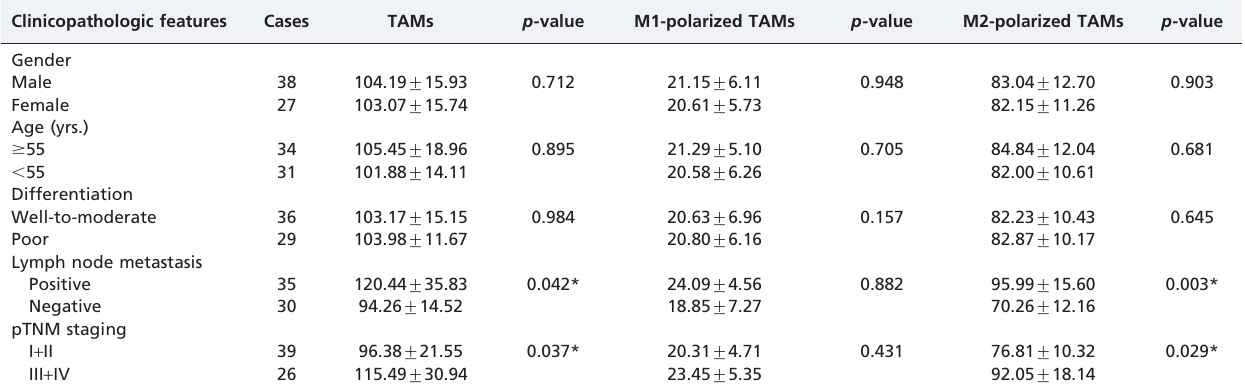
Table 1 - The relationships between TAM, M1- or M2-polarized TAM counts and clinicopathologic features ( (cid:2) xx ¡ s). Clinicopathologic features